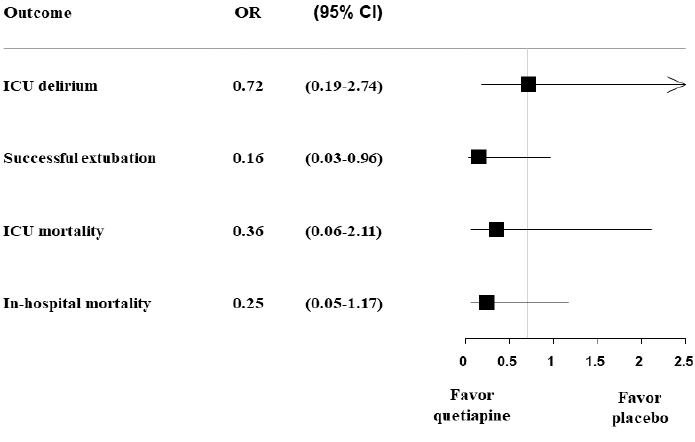
Figure 3. Forest plot of the delirium ‐ related outcomes. Table 2. Clinical outcomes related to ICU delirium.